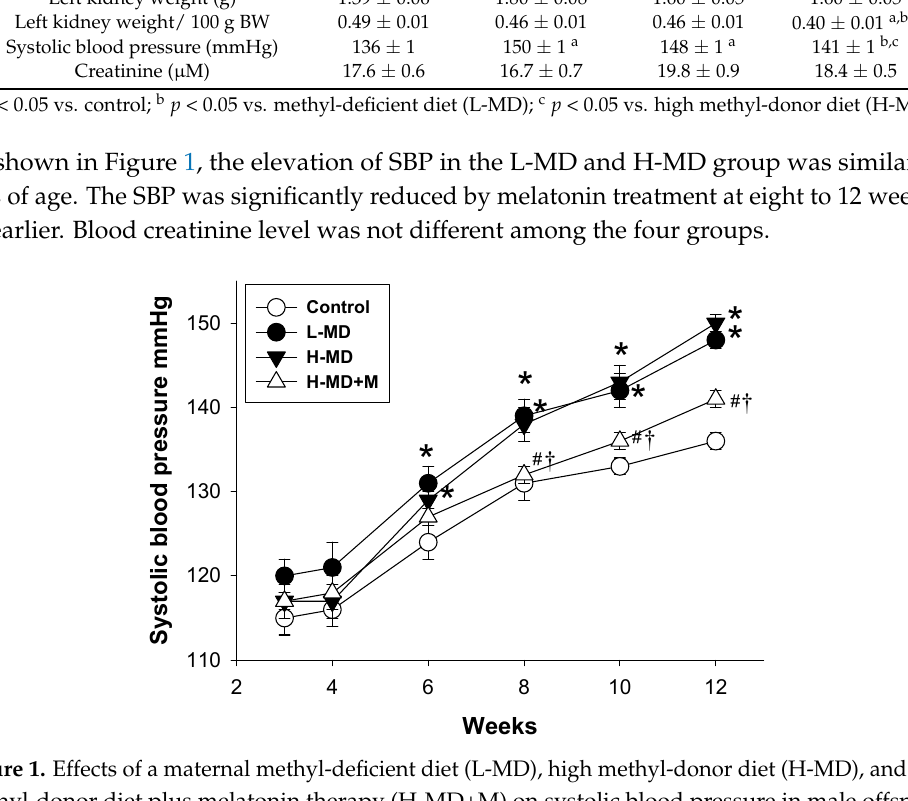
Table 2. Summary of morphological values and blood pressure.